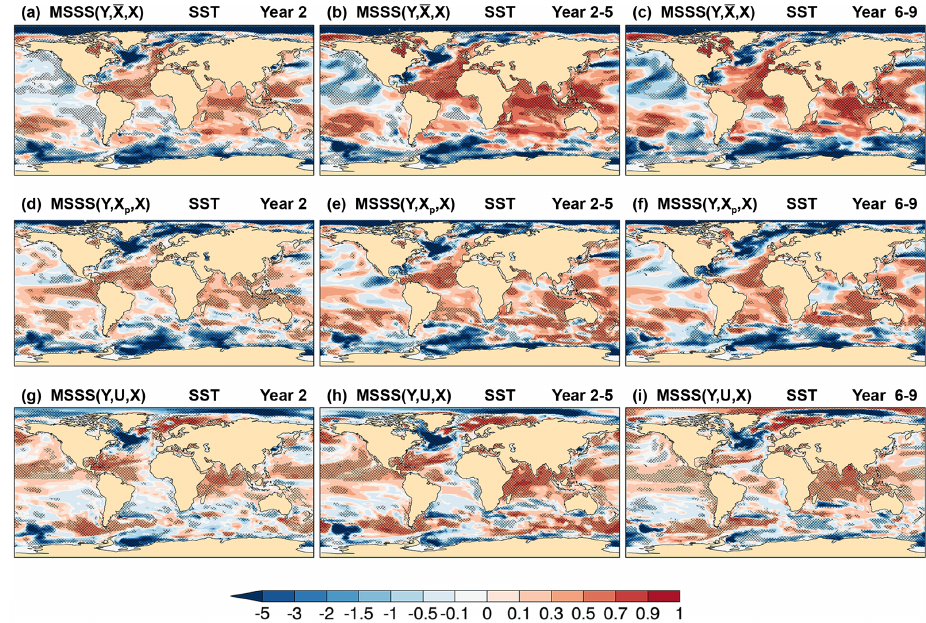
Figure 6. Skill of CanESM5 annual and multi-year mean sea surface temperature hindcasts. MSSS of (a, d, g) Year 2, (b, e, h) Year 2–5, and (c, f, i) Year 6–9 hindcasts, Y , relative to (a–c) observed climatology, X , (d–f) persistence forecast, X p , and (g–i) uninitialized simulations, U . The verifying observations are from the ERSSTv5 data set (Appendix B). Cross-hatched regions indicate values significantly different from zero at the 90% confidence